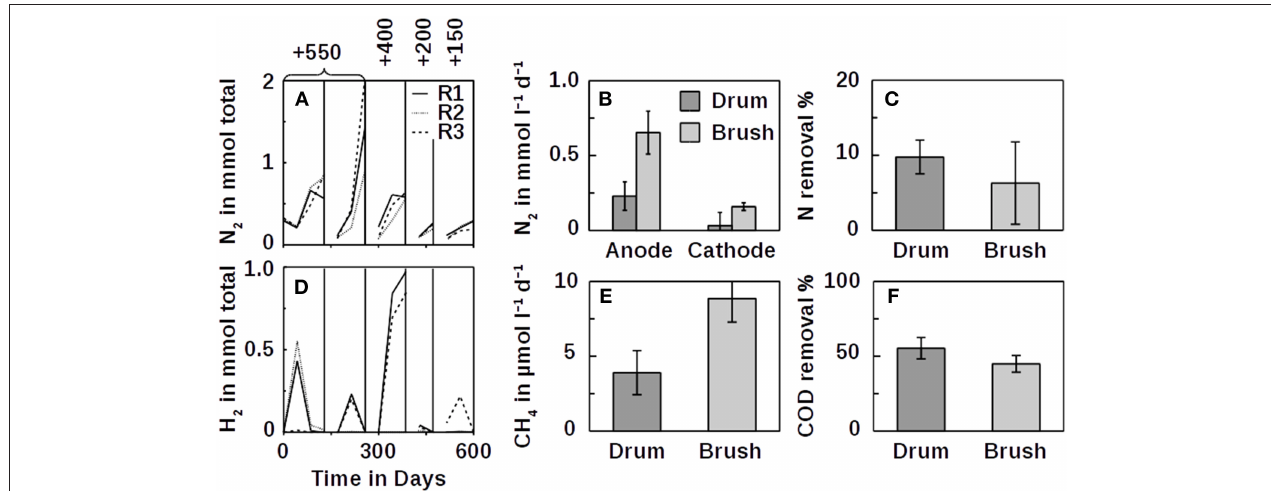
FIGURE 2 | Anodic N 2 accumulation ( A , mineral medium; B , wastewater), nitrogen removal from wastewater (C) , cathodic H 2 production ( D , mineral medium) and CH 4 production ( E , wastewater), and COD removal from wastewater (F) . Nitrogen production of the drum reactors in (B) is shown with the open circuit control subtracted. No such control was performed for the brushes. Voltages are against a standard hydrogen electrode (SHE). Individual fed-batch cycles in (A,D) are separated by vertical lines. Poised potentials in (A,D) are shown on top vs. an SHE in mV. Lines connecting individual data points are not interpolations and merely indicate trends. The anode drum was a titanium mesh cylinder filled with graphite granules, and the anode brush was a conventional carbon brush. Errors are standard deviations of their means within 97% confidence